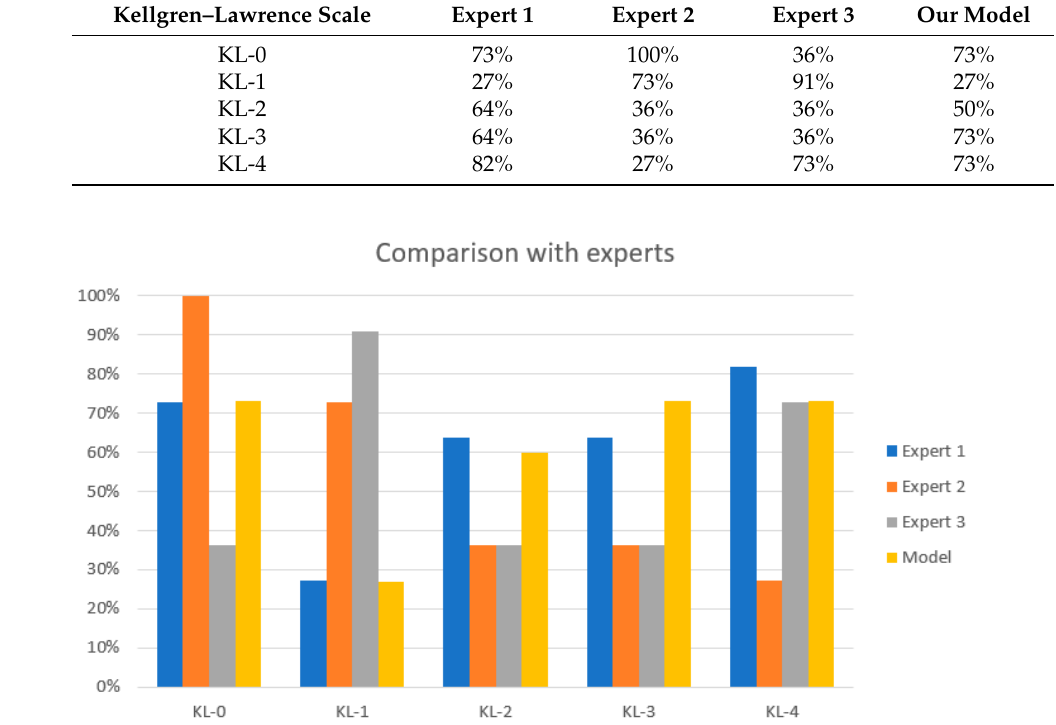
Table 4. Model comparison to other models according (kappa an average multiclass